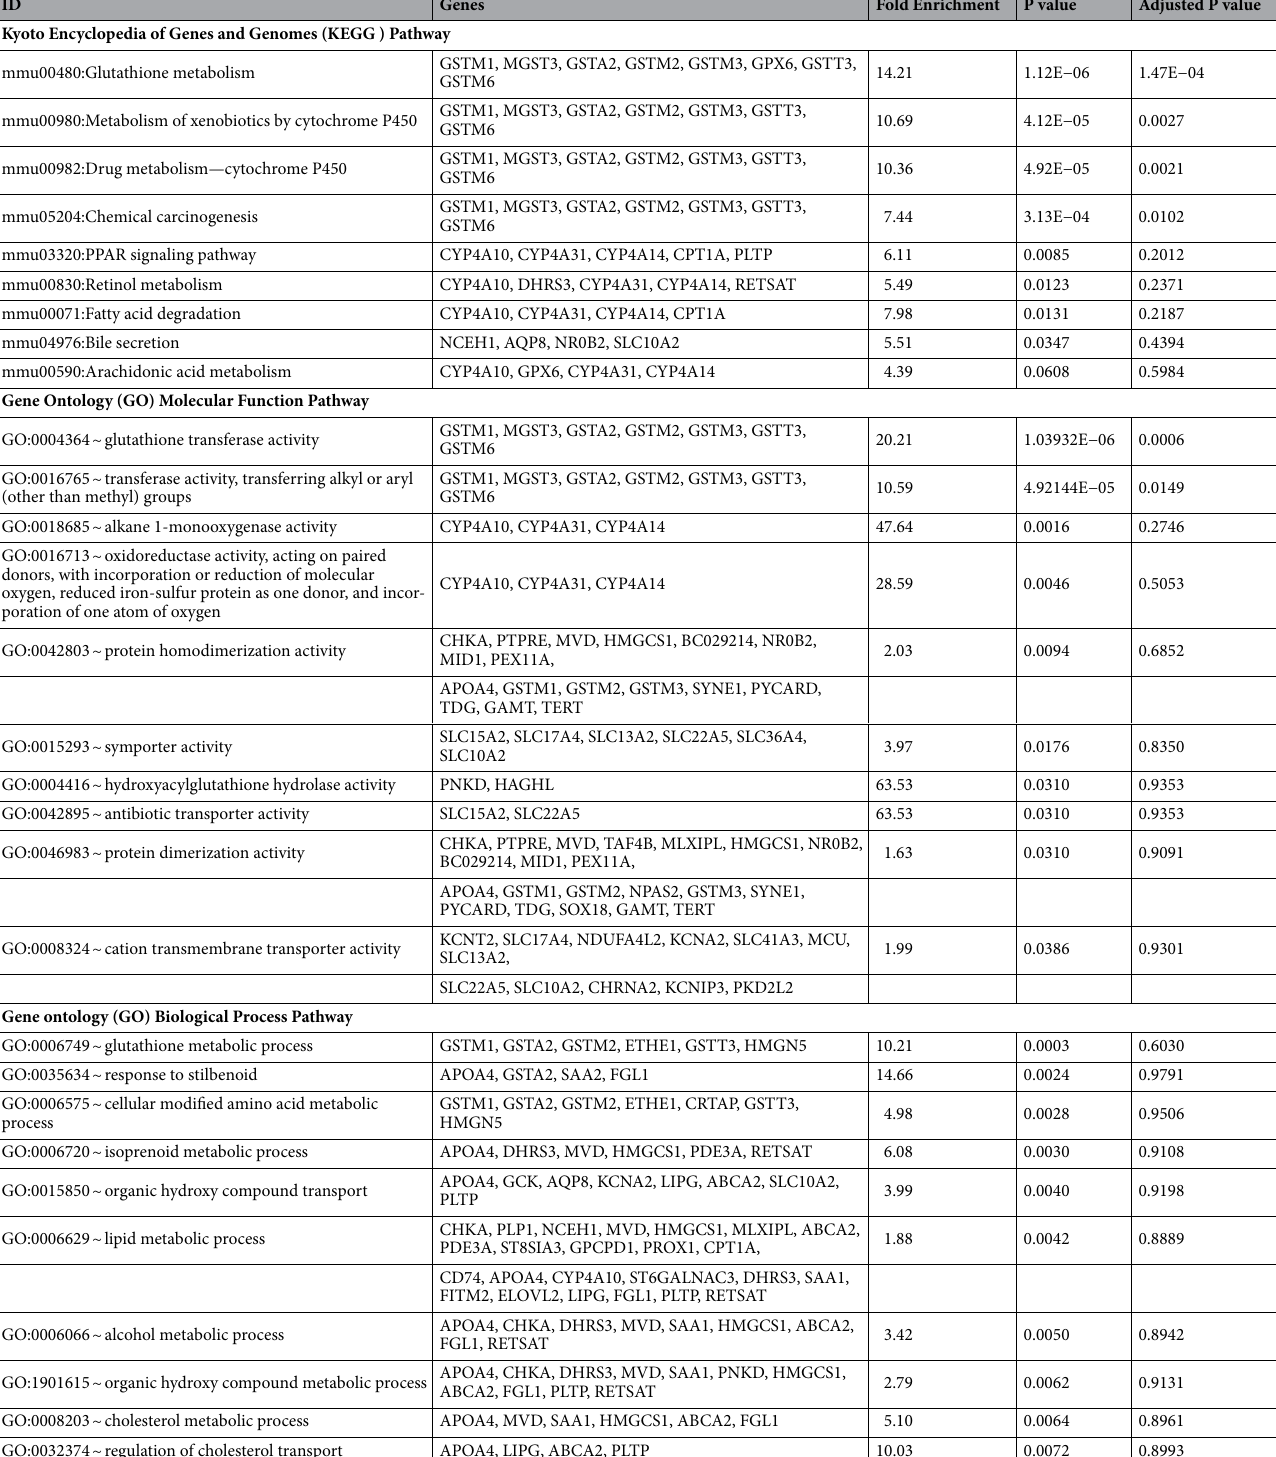
Table 1. Hepatic Transcriptome Analysis of Arthritic PON1Tg Mice Compared to Arthritic Control Mice after Adjustment for Baseline Non-arthritic PON1Tg/Control